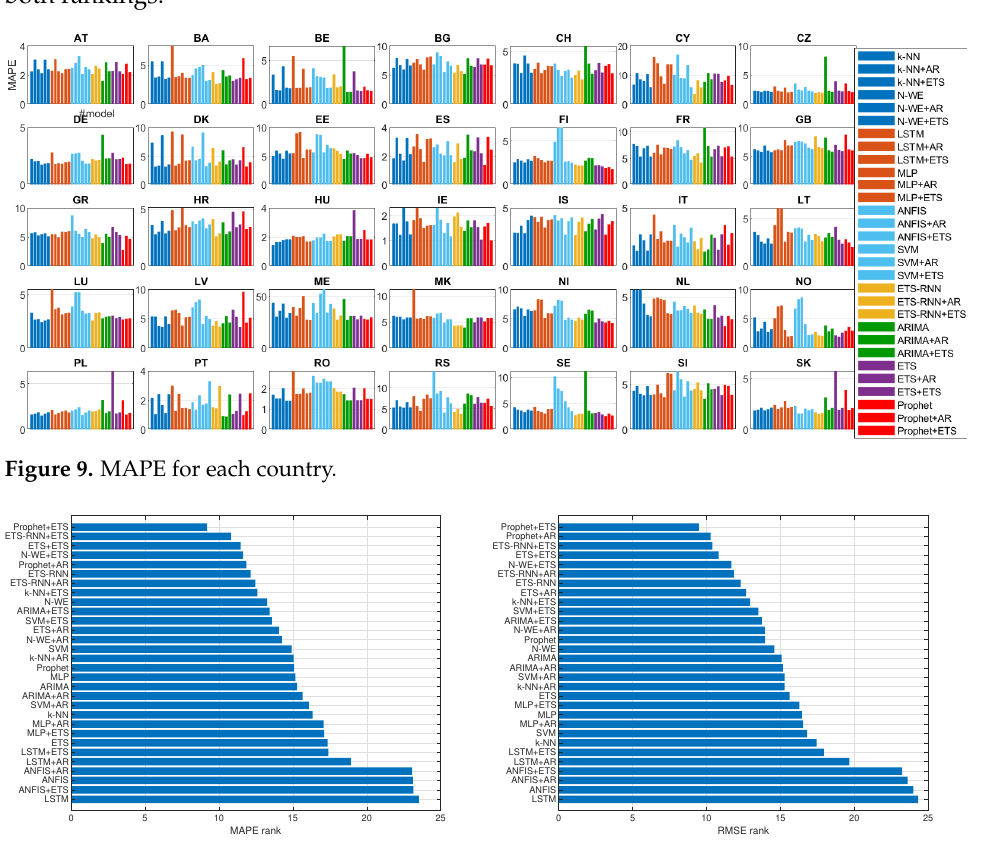
Figure 10. Rankings of the